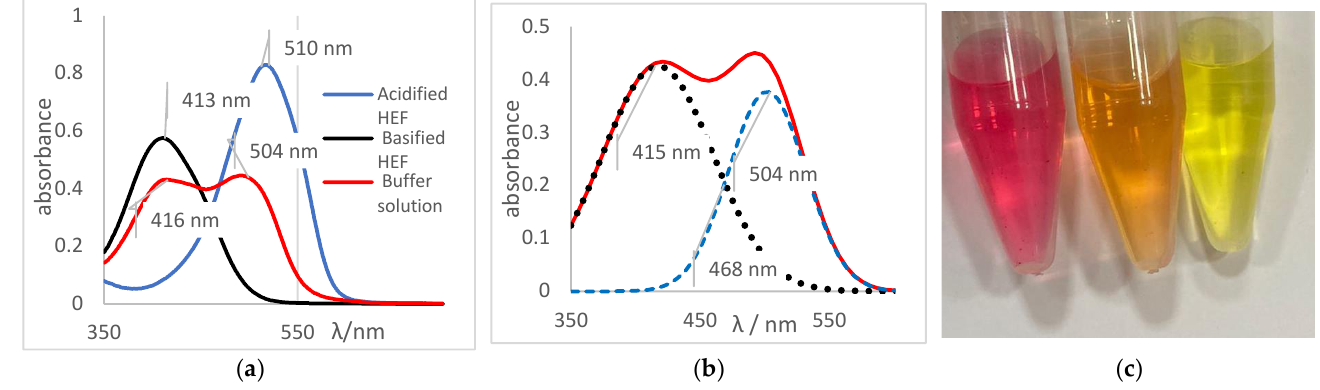
Figure 7. ( a ) Spectrum of the methyl red indicator. Blue: acidified HEF solution. Black: basified HEF solution. Red: buffer solution; ( b ) Deconvolution of the buffer solution curve; ( c ) Visual perception.